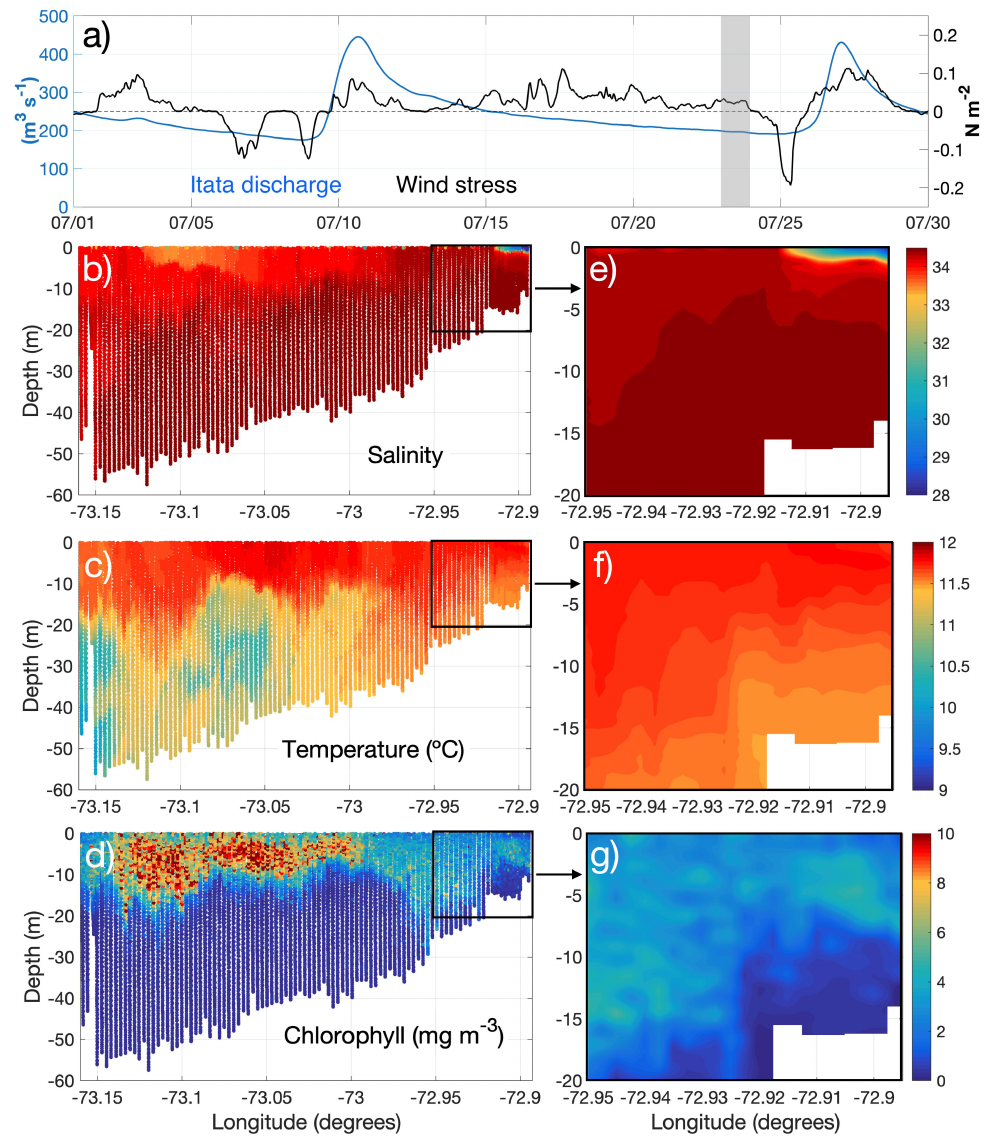
Figure 10. Cross-shore hydrographic section from a towed RapidPro CTD on 23 July 2021 off the Itata River mouth. High-resolution data (no interpolation) for ( b , e ) salinity, ( c , f ) temperature, and ( d , g ) chlorophyll are shown for the entire section (left panels), whereas the shallower inner shelf area (enclosed black box) is presented after applying objective interpolation (right panels) for better visualization. The history of meridional wind stress and river discharge during July 2021 is also presented in ( a ) where the shaded area indicates the day of hydrographic measurements. Note that upwelling-favorable winds characterized the week previous to the hydrographic